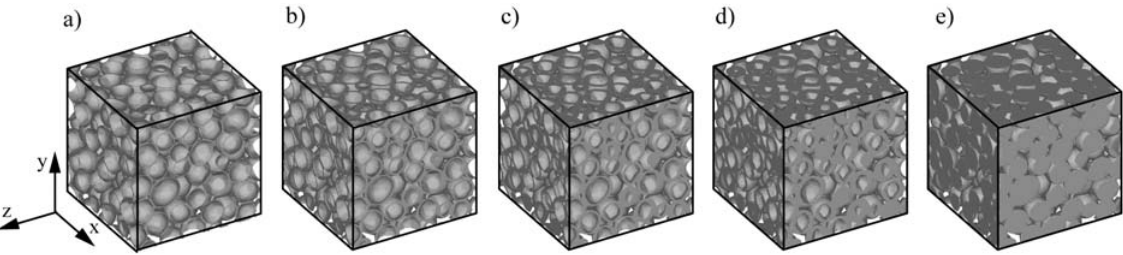
= 0.15; ( b ) t r / r = 1.0 ρ w